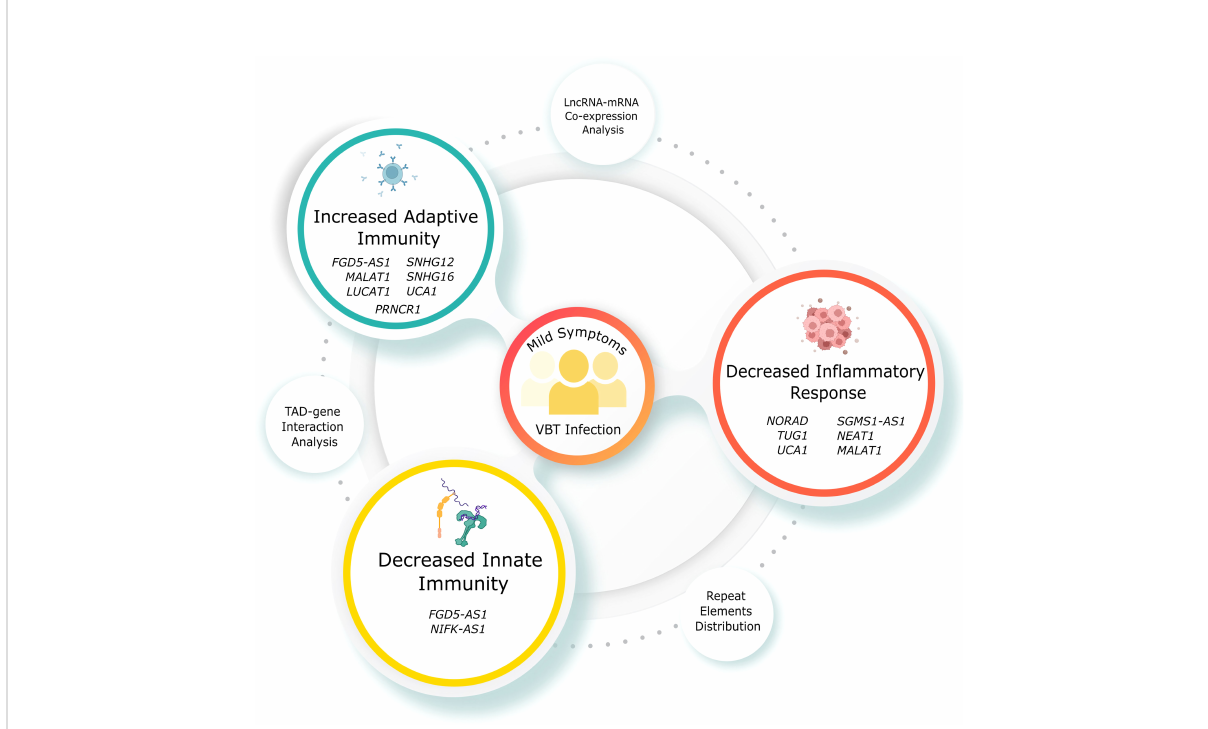
FIGURE 6 Mechanism explaining the mild symptoms in VBT SARS-CoV-2 infection. Didactic fi gure showing the speci fi c lncRNAs modulating the immune and in fl ammatory response resulting in the mild symptoms in the VBT